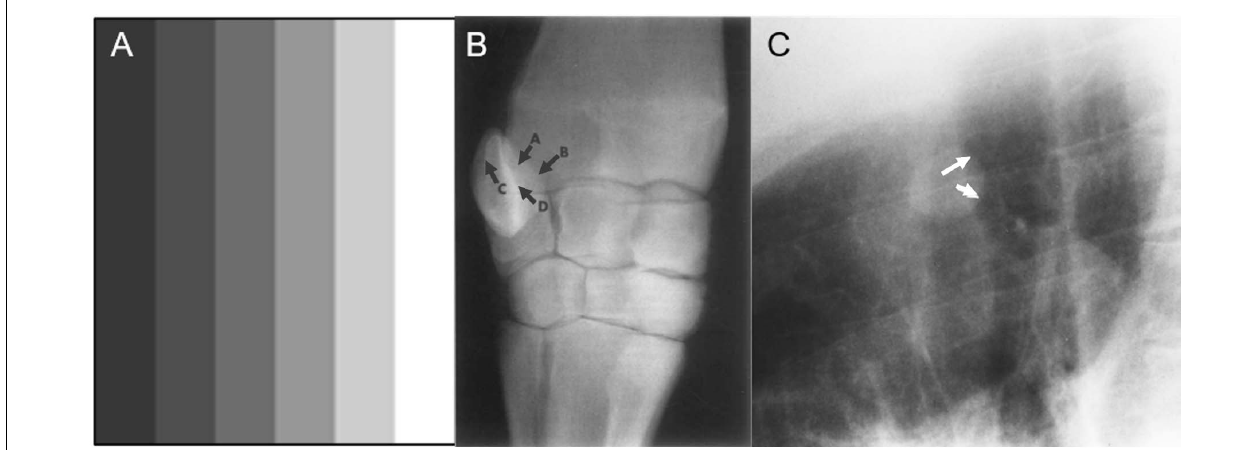
FIGURE 1 | Examples of Mach bands. Classical Mach bands are apparent along the vertical edges of the stripes (A) . Although each individual stripe is physically uniform, its contrast intensity appears to differ between the left and the right edge, due to their respective proximity to adjacent bars with other luminances. Thus, at the border of any two adjacent bars, the edge of the lighter bar appears even lighter than in reality (a positive Mach band), while the edge of the darker bar appears even darker (a negative Mach band). (B) Radiograph of the carpus of a horse, in which some convex boundaries (arrows A,B), are associated with negative Mach bands, becoming almost imperceptible. Some concave boundaries (arrows C,D) are opaque and have prominent positive Mach bands. In this way, Mach bands provide shape cues: positive Mach bands may signal a concave shape, where negative Mach bands may signal a convex shape (from Papageorges, 1991). (C) A negative Mach band (arrows) helps define the nodule on this lateral radiograph (from Chasen, 2001).